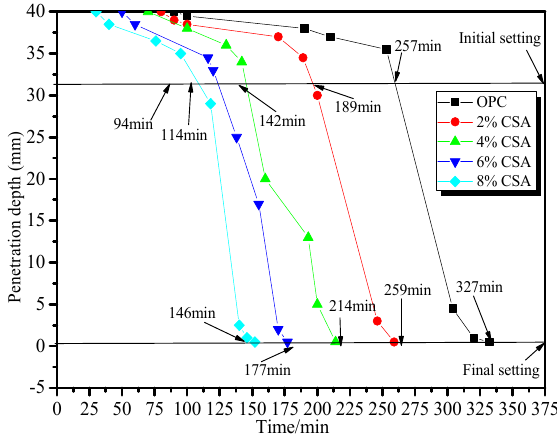
Figure 1. Effect of the CSA cement on the setting time of the OPC